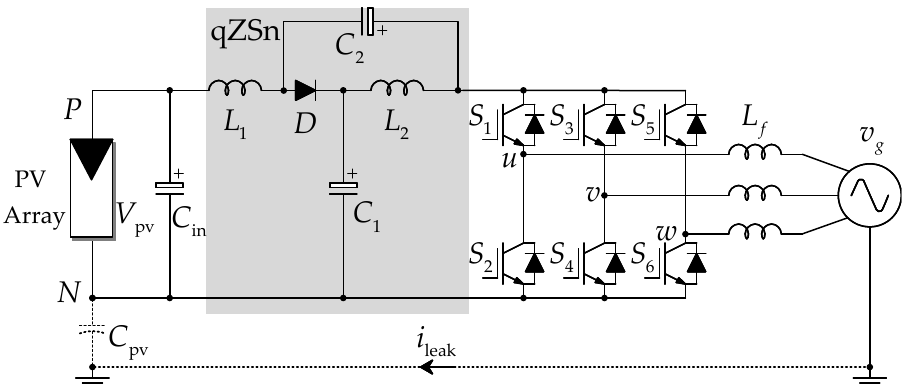
Figure 1. Schematic of a three-phase grid-connected quasi-Z-source inverter system, where the quasi-Z-source network (qZSn) consists of two inductors L 1 , L 2 , two capacitors C 1 , C 2 and a diode D , L f is the output filter, v g is the grid voltage, C pv is the parasitic capacitance between the PV array and the ground and i leak is the leakage